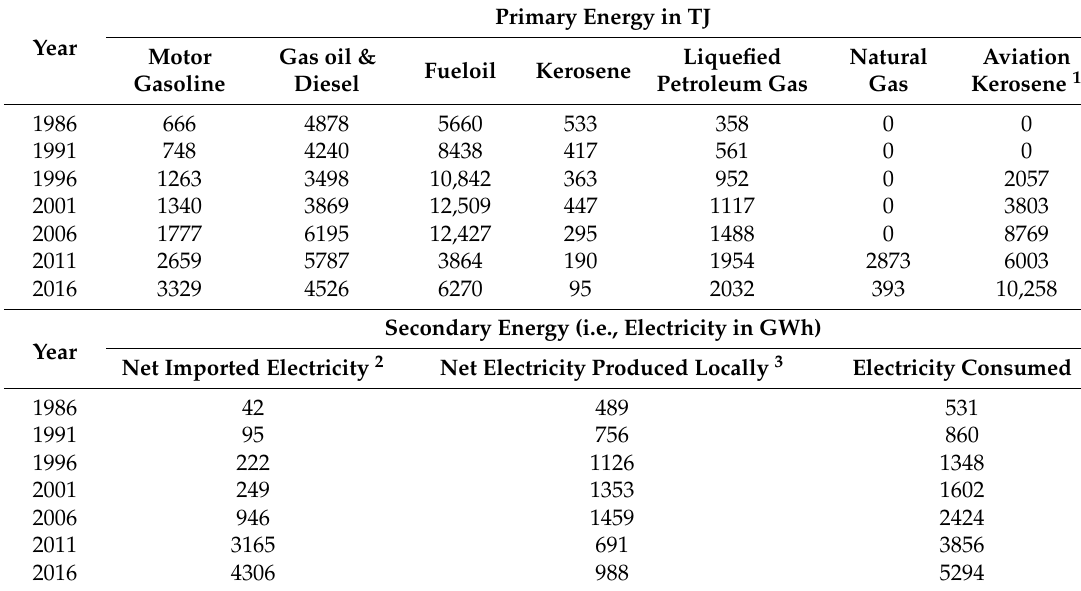
Table 1. Import of fossil fuels (primary source of energy) in 1986, 1991, 1996, 2001, 2006, 2011, and 2016.